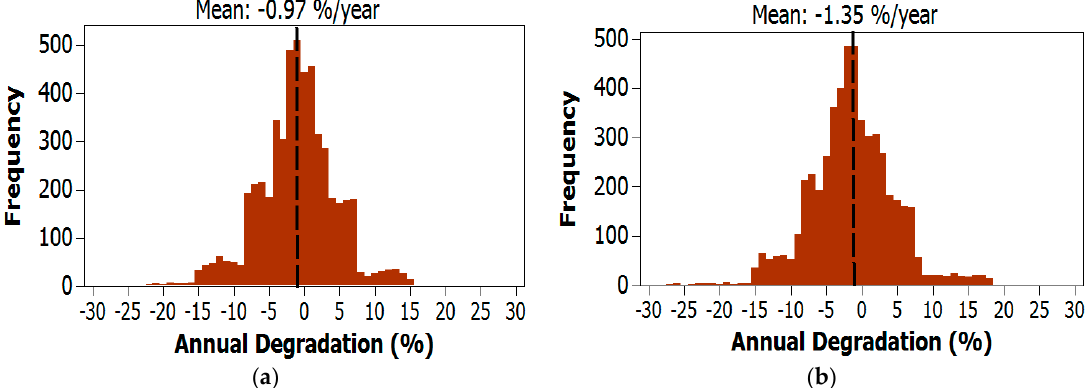
Figure 5. Degradation rate analysis per PV array for PV systems installed in Aberdeen: ( a ) first PV array annual degradation rate − 0.97%/year; ( b ) second PV array “affected by three hot-spotted PV modules” annual degradation rate of − 1.35%/year.